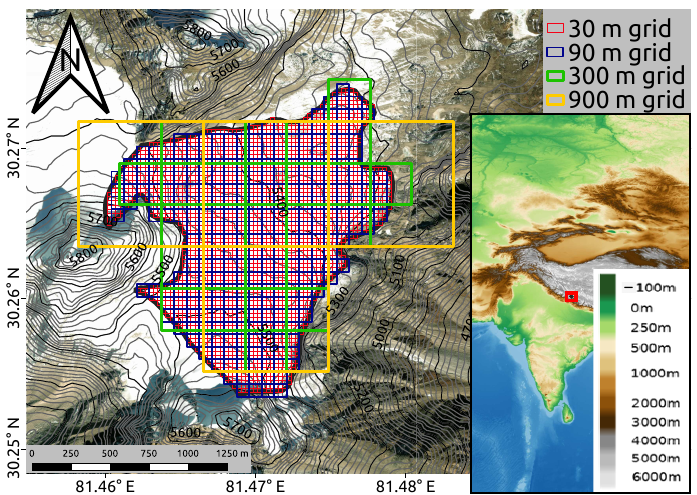
Figure A4. Differently resolved spatial grids over Halji glacier based on the glacier outline from Randolph Glacier Inventory 6.0 [45] and with a satellite image map as background from [55]. Colors within the inset map represent elevation